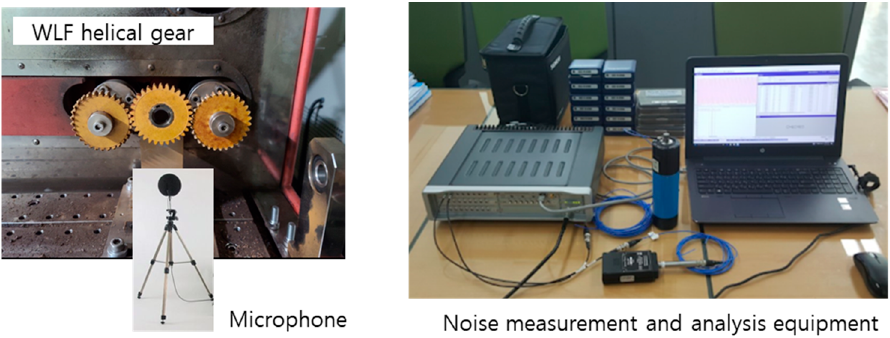
Figure 7. Noise measurement of the WLF helical gear.